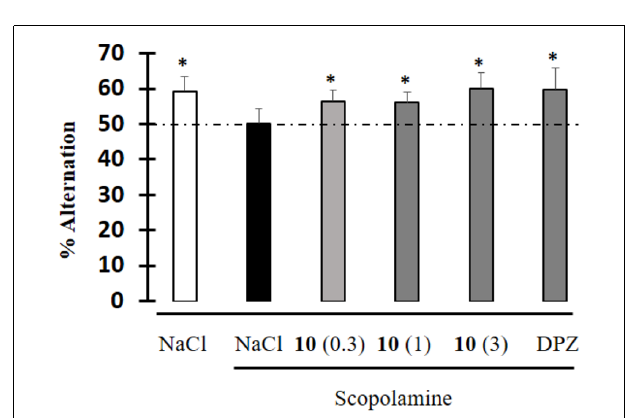
FIGURE 6 | Effect of compound 10 on scopolamine-induced impairment during the spontaneous alternation test. Data are expressed as the mean ± standard deviation ( n = 8). Drugs were administered IP 30 min before the test, and scopolamine was administered SC 20 min before the test. Compound 10 : 0.3, 1, 3 mg/kg; DPZ: Donepezil; 1 mg/kg; Scopolamine: 0.5 mg/kg ( ∗ p < 0.05 vs. 50%; univariate t